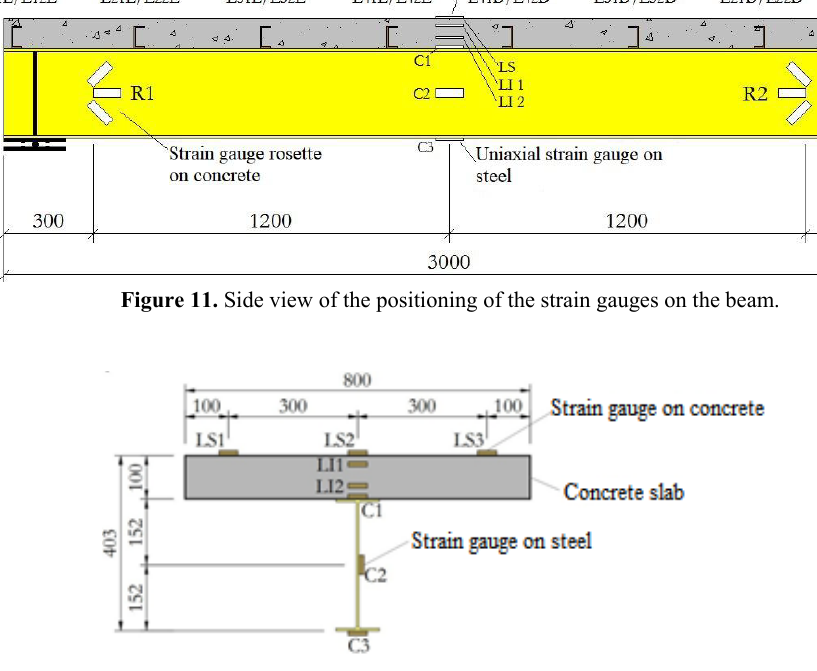
Figure 12. Cross section of the positioning of the strain gauges on the beam.